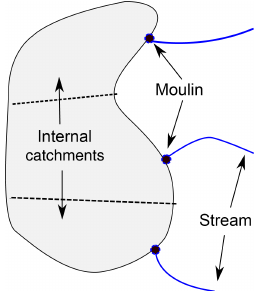
Figure 3. Schematic drawing showing the conceptual model of the crevasse drainage implemented. Shaded area indicates a crevasse field. Moulins are assumed to occur where high-flux supraglacial streams intersect the crevasse field. The crevasse field is then parti- tioned using Voronoi partitioning into internal catchments. All melt which occurs within an internal catchment is assumed to drain into the subglacial system at the corresponding moulin.